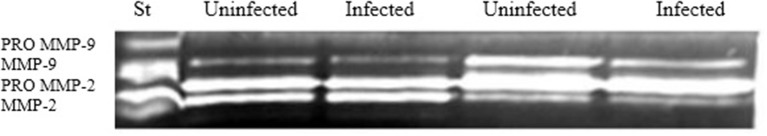
MMP-9 gelatinase activity. Supernatants from control and infected explants were analyzed by gelatin zymography to evaluate MMP-9 activity (n = 7). No significant changes were observed after densitometric analysis.